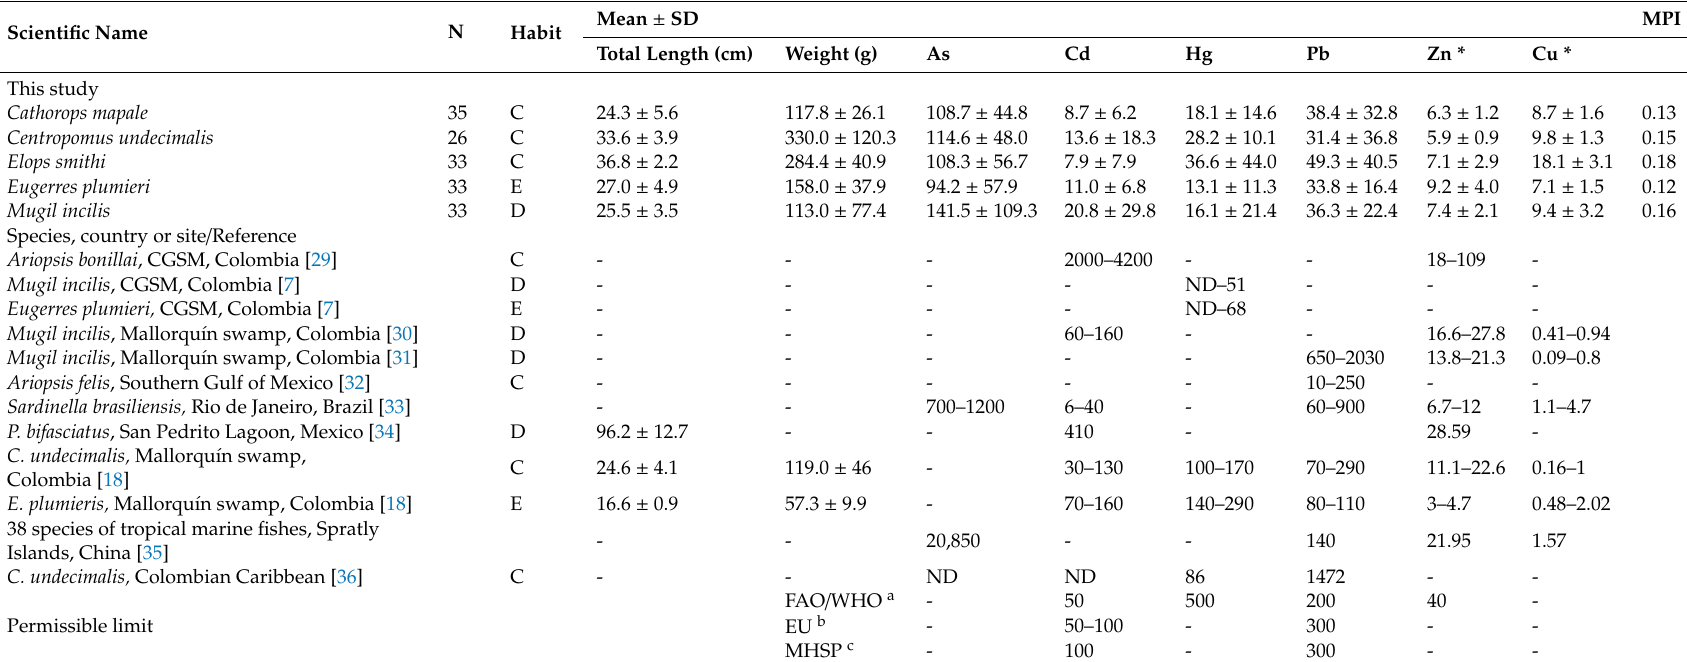
Table 1. Concentrations of heavy metals ( µ g / kg) found in fish species assessed and values reported in other studies